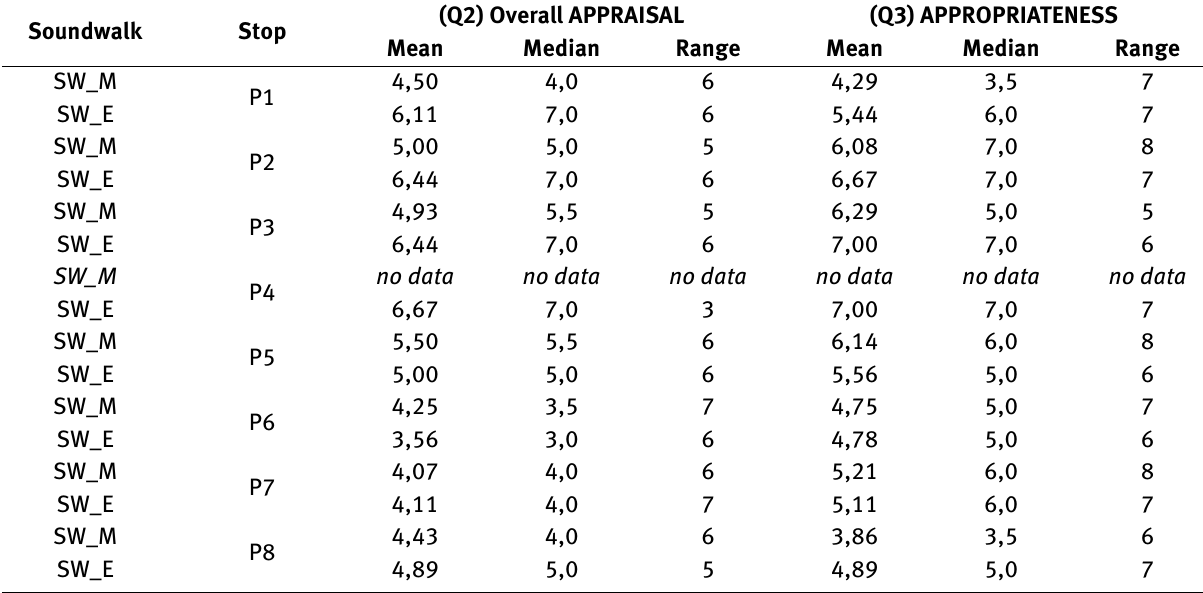
Table 3: Analysis of answers to questions Q2 (overall appraisal) and Q3 (appropriateness) at stop sites during the morning (SW_M) and evening (SW_E)